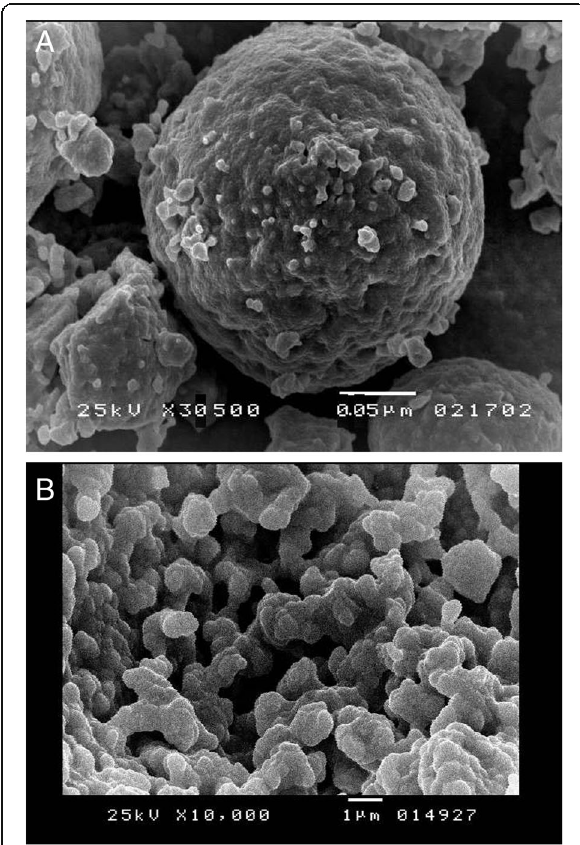
Fig. 1 a SEM image, ×10,000, demonstrating internal porosity of the fabricated zirconia scaffolds. b SEM image, ×30,500, demonstrating agglomeration of nano-hydroxyapatite particles filling the porous structure